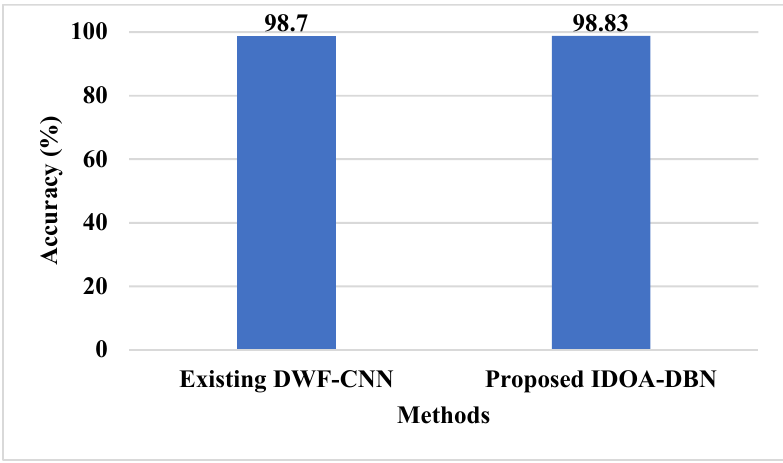
Figure 7. Graphical illustration of accuracy with existing method.